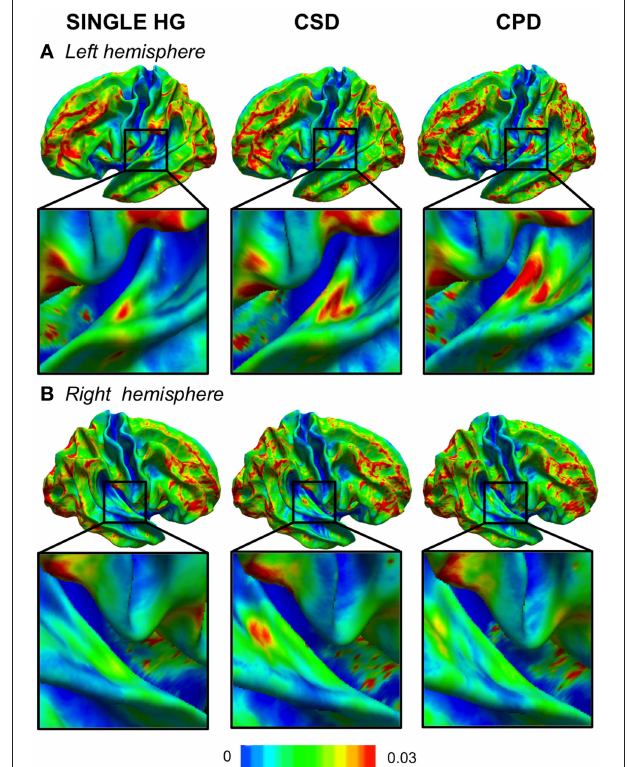
FIGURE 2 | Variability maps of the curvature (CURV) parameter in the left (A) and right (B) hemispheres. The color scale represents the variance of the CURV parameters computed for each HG gyrification pattern in each hemisphere. The zoomed part is centered in the temporal transverse region where the HG duplication is